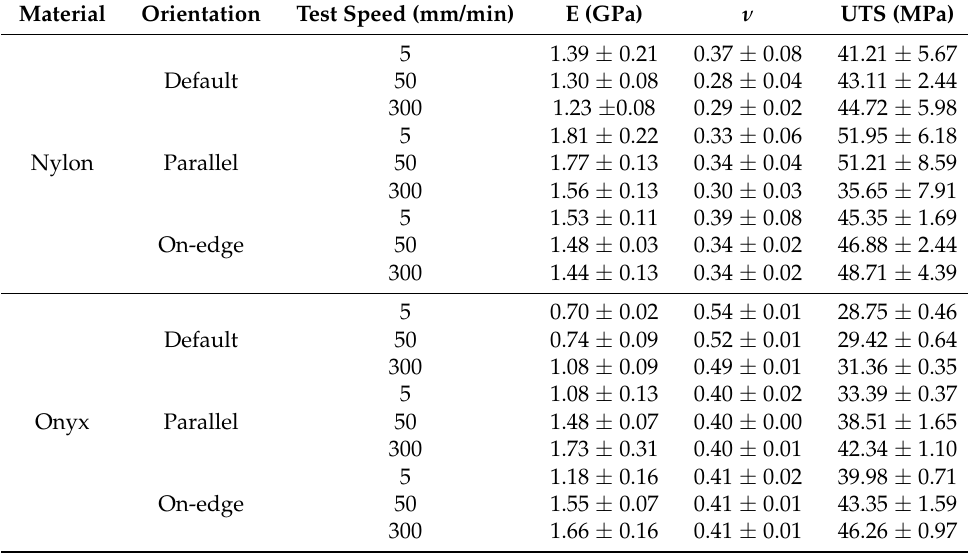
Figure 7. Variation of tensile properties of nylon with strain rate and orientation: ( a ) ultimate tensile stress, ( b ) longitudinal modulus, and ( c ) Poisson’s ratio. Table 2. Tensile properties of Nylon and Onyx: elastic modulus (E), Poisson’s ratio ( ν ) and ultimate tensile stress (UTS).